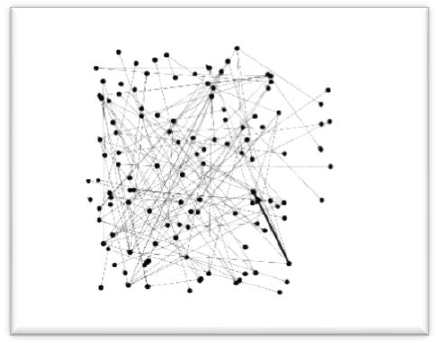
Figure 8. Example of Edges Graph.